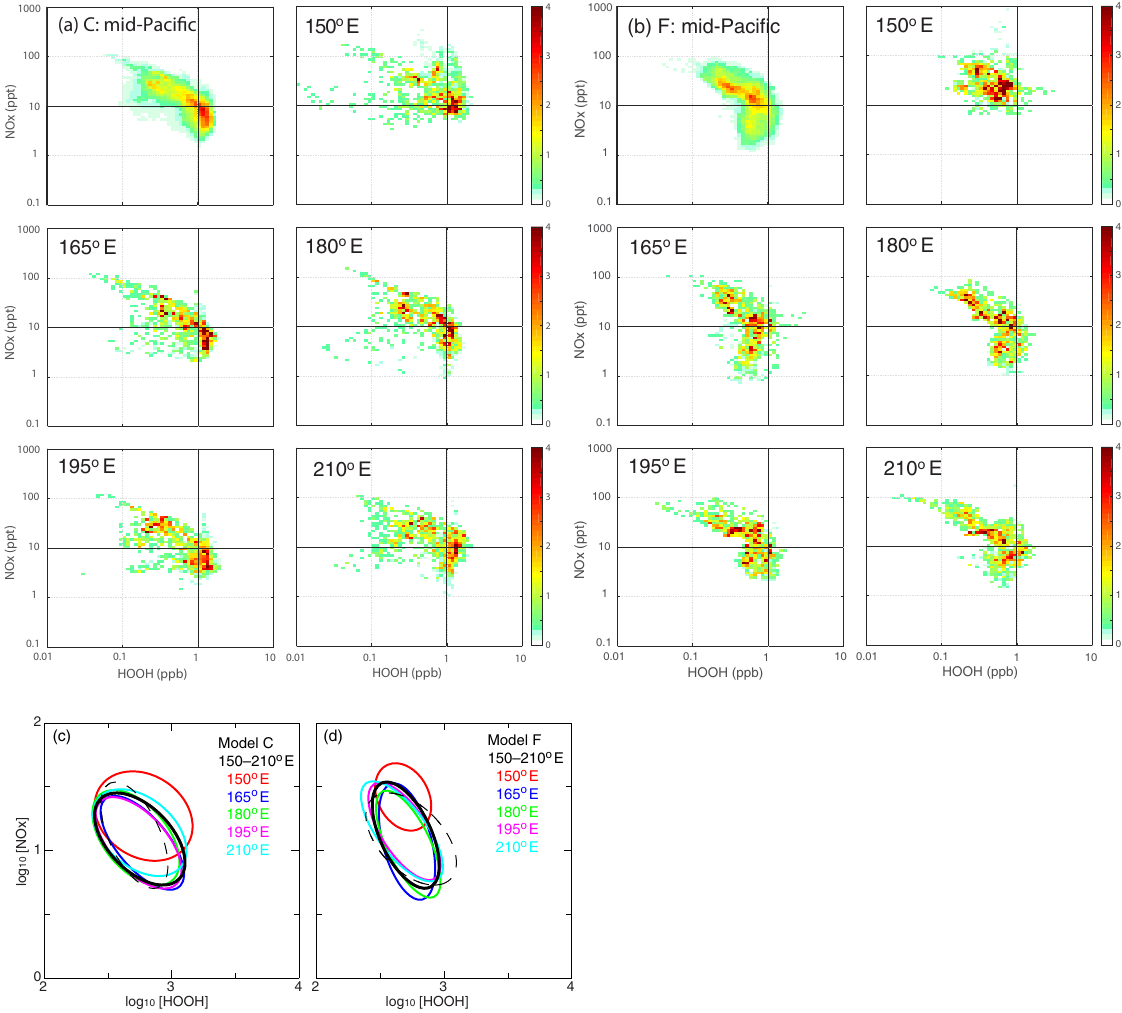
Figure 8. AIR-weighted 2-D probability distributions for NO x vs. HOOH averaged over tropical Pacific block (150–210 ◦ E, 20 ◦ S–20 ◦ N, 0–12km) and for different single-longitude transects from 150–210 ◦ E, shown for models (a) C (GFDL-AM3) and (b) F (UCI-CTM). The fitted 2-D ellipses are shown for the full block (thick black line) and five longitude transects (colored lines) for models (c) C and (d) F. The block ellipse for the other model is shown as a thin black dashed